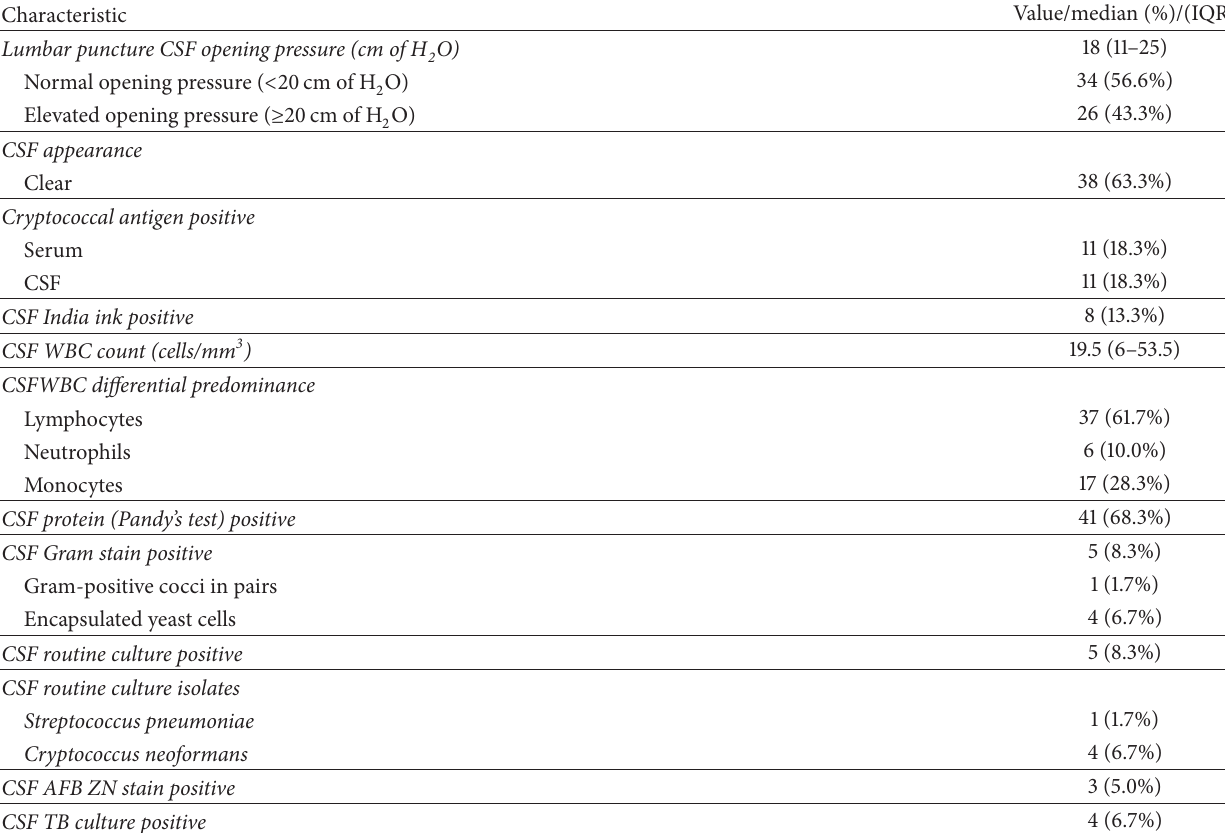
Table 2: Admission lumbar puncture findings in HIV-infected adults admitted with features of meningitis to the medical wards of Bugando Medical Centre between November 2012 and May 2013 ( 𝑛 = 60